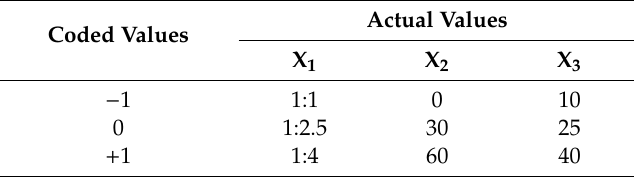
Table 7. Actual and coded values of independent